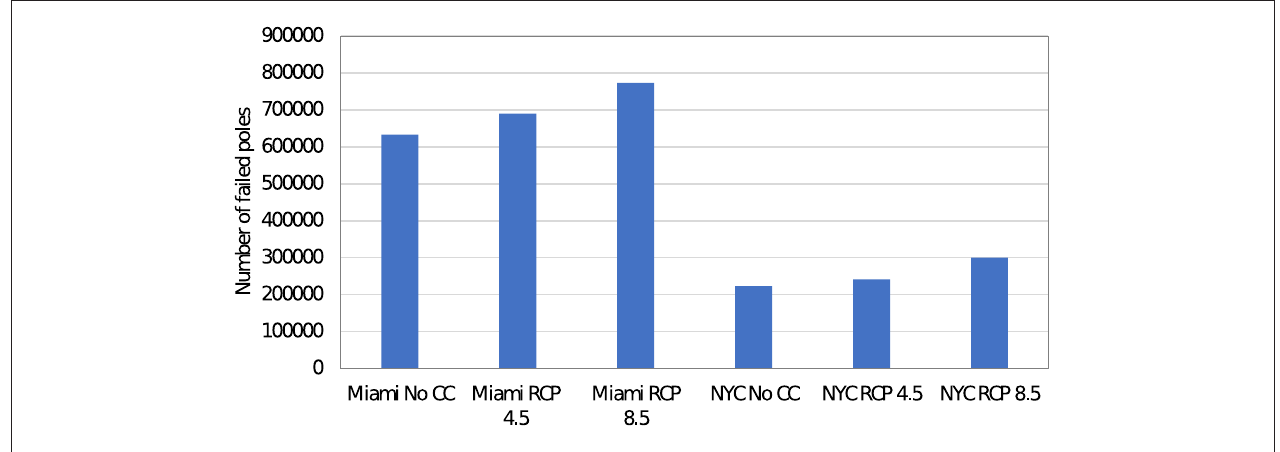
FIGURE 7 | Comparison of the total number of failed (replaced) poles (2010–2099).